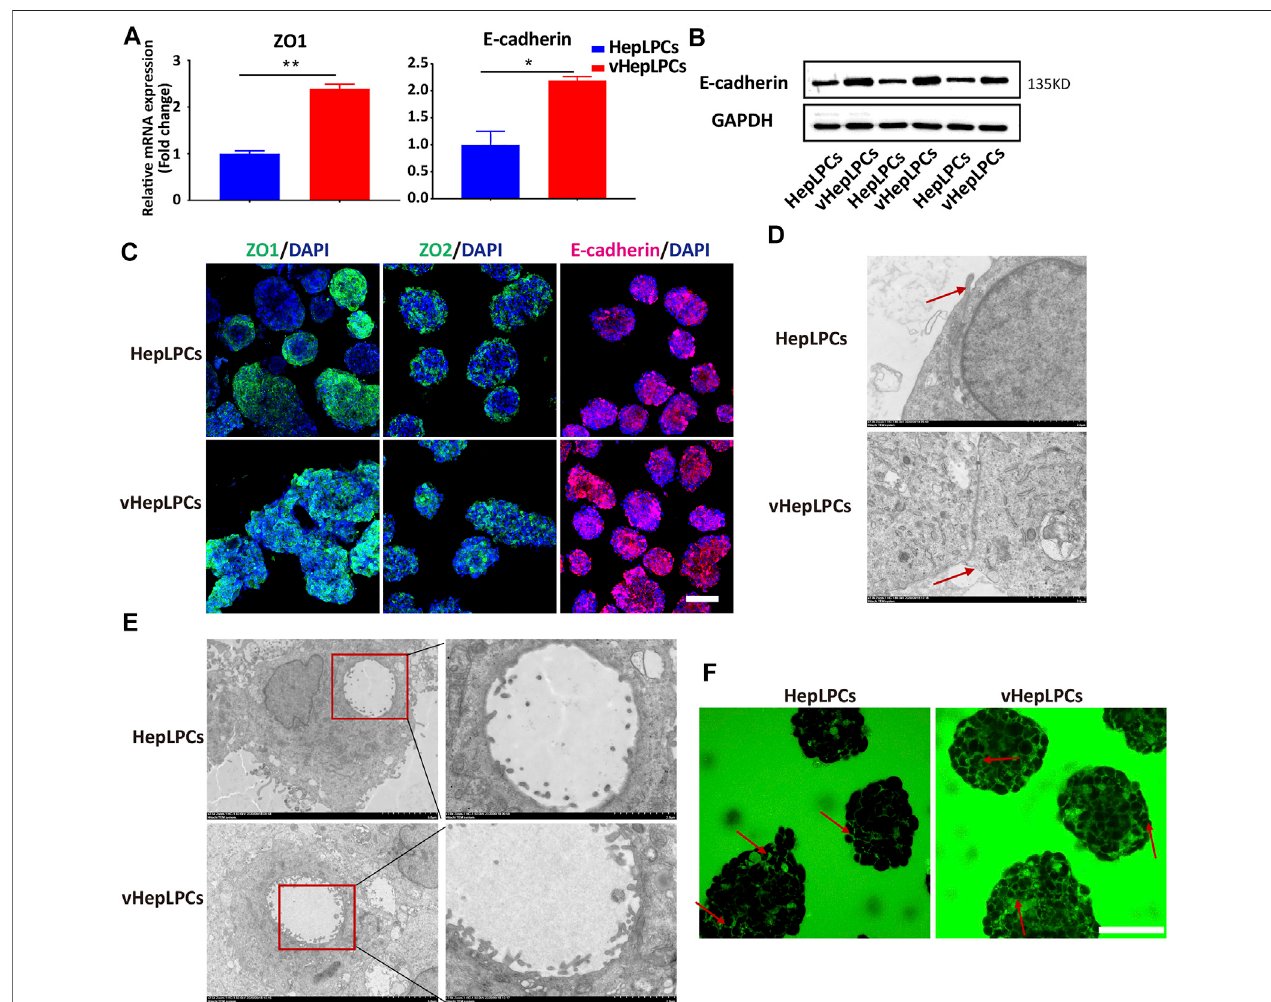
FIGURE4| Co-cultureofHepLPCsandHUVECsenhancedcell-celltightjunctions. (A) GeneexpressionwasanalyzedbyqRT-PCR.Tightadhesionmarkers(ZO1, E-cadherin) were assessed. Data are normalized to HepLPCs. (B) Western blot analysis of the expression of E-cadherin in two groups ( n (cid:2) 3). (C) Immuno fl uorescent staining analyses of the expression of the tight junction markers, ZO1, ZO2, and E-cadherin, in HepLPCs and vHepLPCs. Nuclei were counterstained with DAPI. (D) Transmissionelectron microscopyresults showed tightjunctionsbetweencells. vHepLPCs exhibited more complete tightjunctionsbetweencells, asindicated by the red arrow. (E) Representative TEM images. Electron microscopic analysis showed that the abundance and height of microvilli in vHepLPCs were signi fi cantly higher than in HepLPCs, suggesting that these structures are morphologically equivalent to villi that form in the bile canaliculi. (F) Live-imaging of CDF fl ow pathway from HepLPCs and vHepLPC spheroids. Red arrow pointed that the bile canaliculi network was formed by continuous tight junctions between polarized hepatocytes in vHepLPCs in magni fi cated pictures. Data are presented as means ± SEM. * p < 0.05, ** p < 0.01. Scale bars, 100 µm.